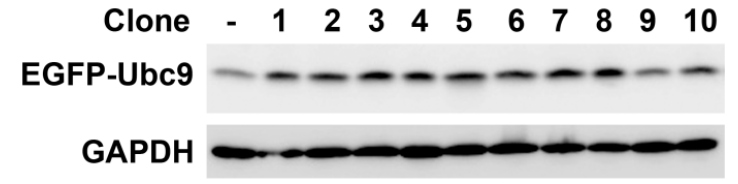
Figure 2. Construction of Ubc9 recombinant plasmid and selection of stable transfected cell clones. The identification of Ubc9 stably overexpressing HO-8910 cells was performed by Western